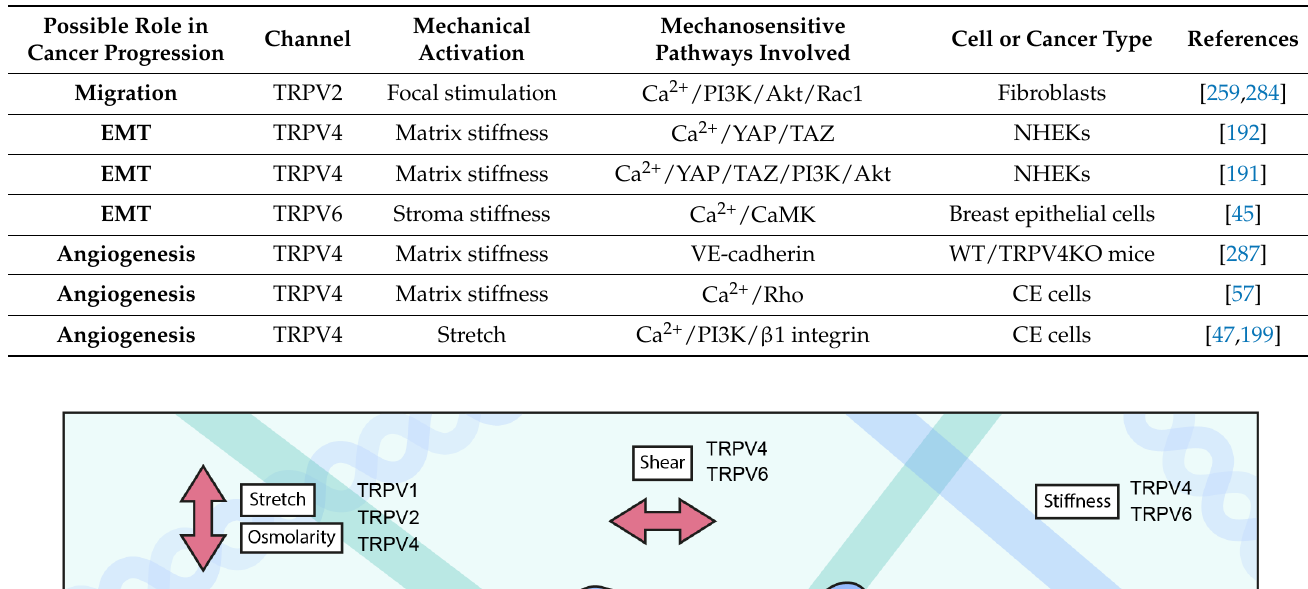
Table 1. Mechanosensitive TRPV channels in cancer progression.